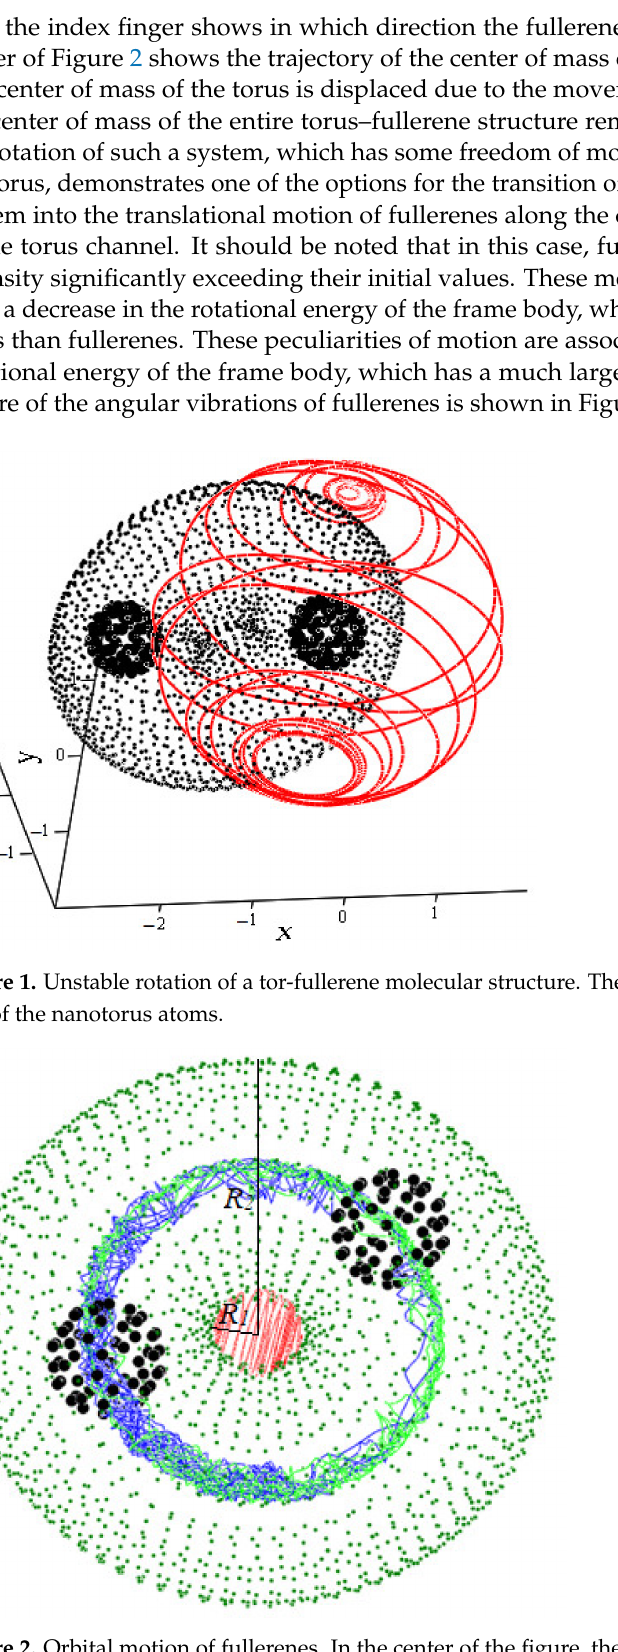
Figure 2. Orbital motion of fullerenes. In the center of the figure, the trajectory of the center of mass of the nanotorus; inside the torus, the trajectory of the centers of mass of